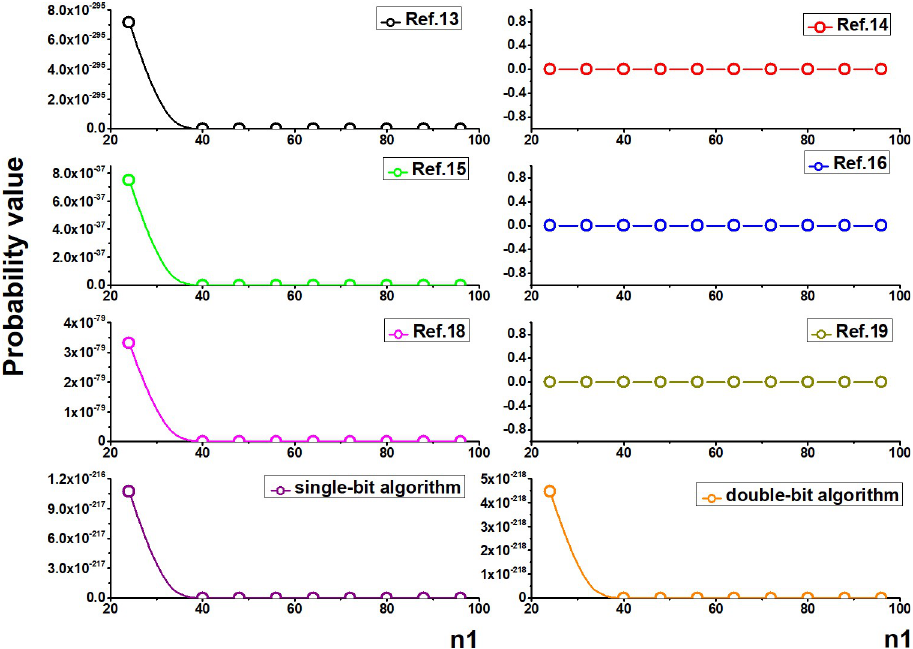
Fig 9. Comparisons of the probability